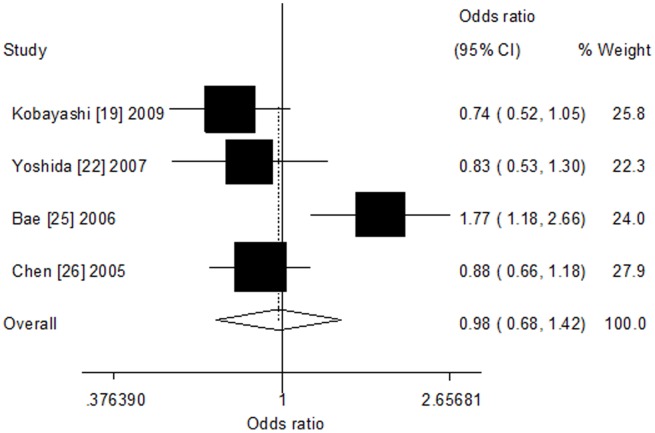
Forest plot of CYP1A2*F polymorphism and colorectal cancer risk among Asians (additive model).